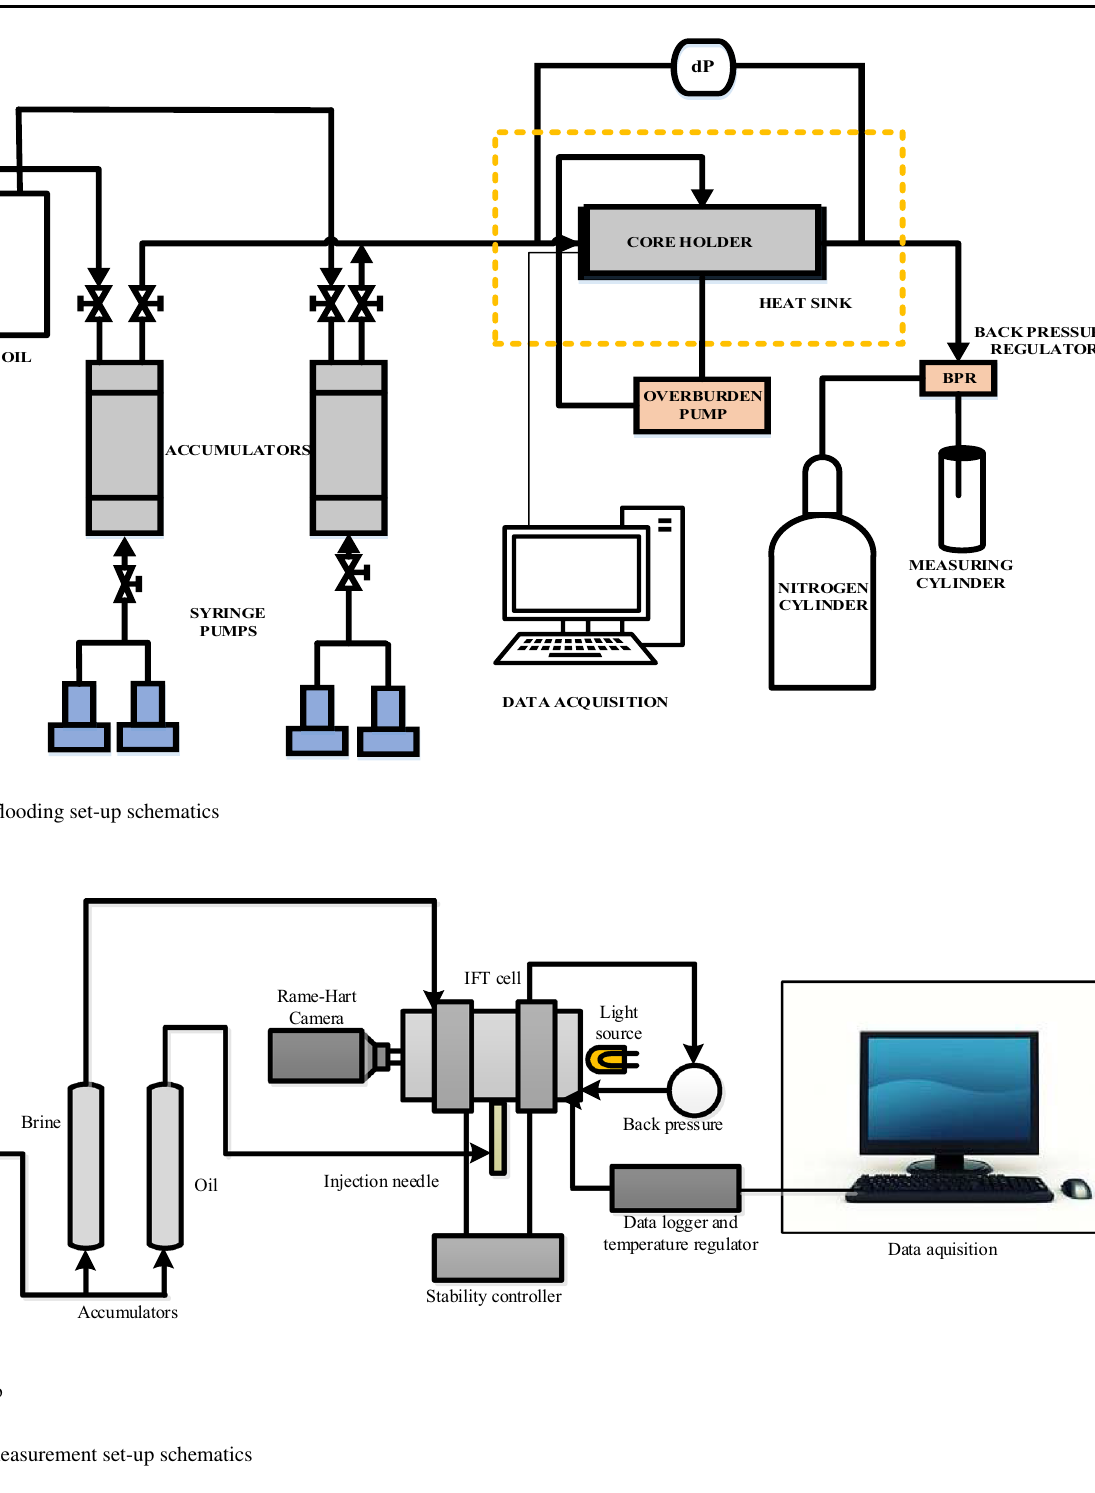
Fig. 5 IFT measurement set-up